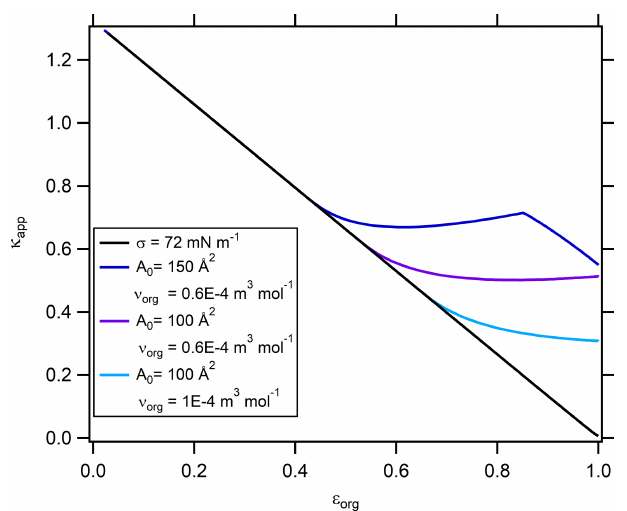
Figure 9. Apparent κ ( κ app ) as a function of ε org for mixed NaCl– organic particles having a constant total diameter (136.8nm), cal- culated using the film model. The black line is the constant σ case, the dark blue line was calculated using A 0 = 150 Å 2 and ν org = 0 . 6 × 10 − 4 , the purple line is calculated using A 0 = 100 Å 2 and ν org = 0 . 6 × 10 − 4 , and the light blue line is calculated using A 0 = 100 Å 2 and ν org = 1 × 10 − 4